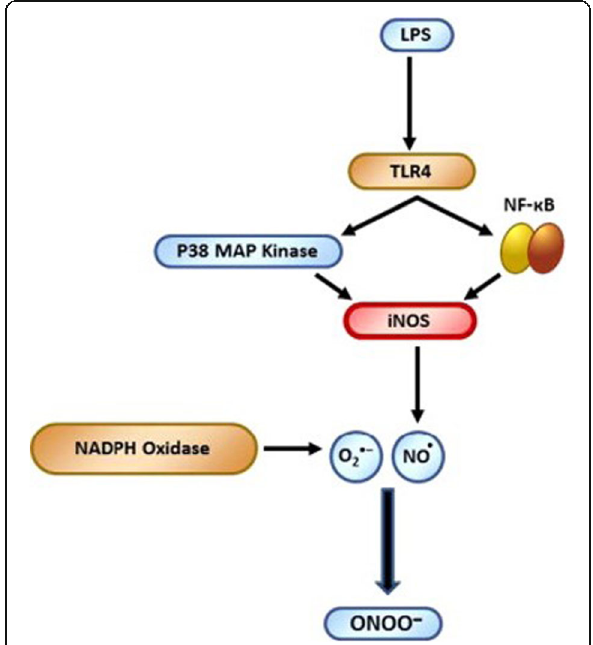
Fig. 1 Production of peroxynitrite via the LPS pathway. LPS — lipopolysaccharide; TLR4 — toll-like receptors; P38 MAP kinase — P38 mitogen-activated pathway kinase; iNOS — inducible nitric oxide synthase; NADPH oxidase — nicotinamide adenine dinucleotide (phosphate); O 2- superoxide; nitric oxide; NF- κ B — nuclear factor kappa-light-chain-enhancer of activated B